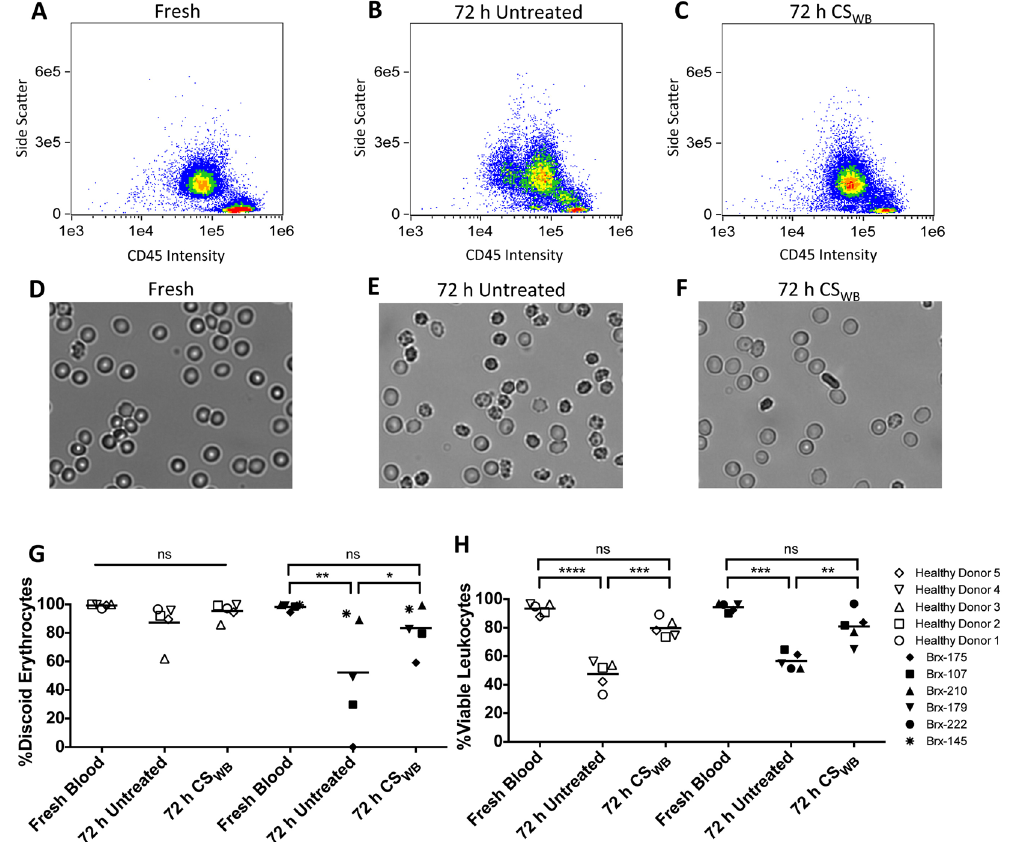
Figure 4. Stabilization of whole blood under ambient conditions. Leukocytes were isolated from whole blood and stained with CD45 and SYTOX Green then analyzed using flow cytometry. ( A ) CD45 v side scatter intensity was plotted for leukocytes obtained from fresh blood for comparison to those stored for 72 h that were either ( B ) untreated (whole blood only) or ( C ) treated with CS WB . In parallel, erythrocytes were examined for each condition including ( D ) fresh control, ( E ) untreated control and ( F ) CS WB -treated after 72 h storage. ( G ) The erythrocytes and ( H ) leukocytes of 5 healthy donors (open symbols) and 5 patients (Brx, closed symbols) were analyzed from fresh blood and following 72 h storage in samples that were CS WB -treated or untreated controls (n = 5, 1-way repeated measures